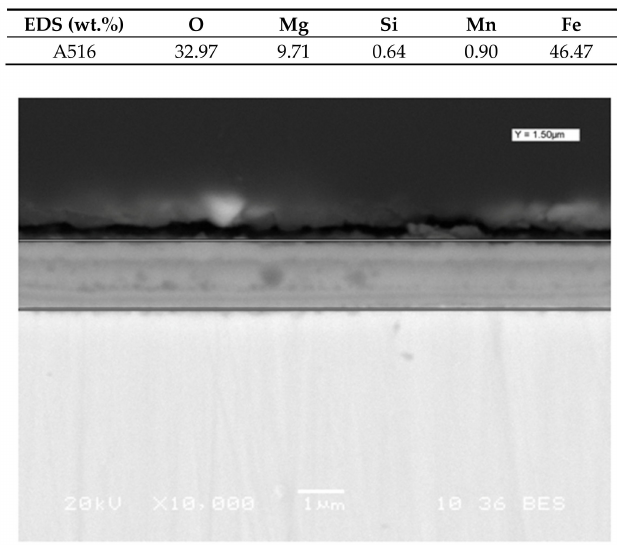
Figure 3. Backscattered cross section study in corrosion layer of A516 at 1000 h of immersion in LiNO 3 ternary molten salt at 390 ◦ C.